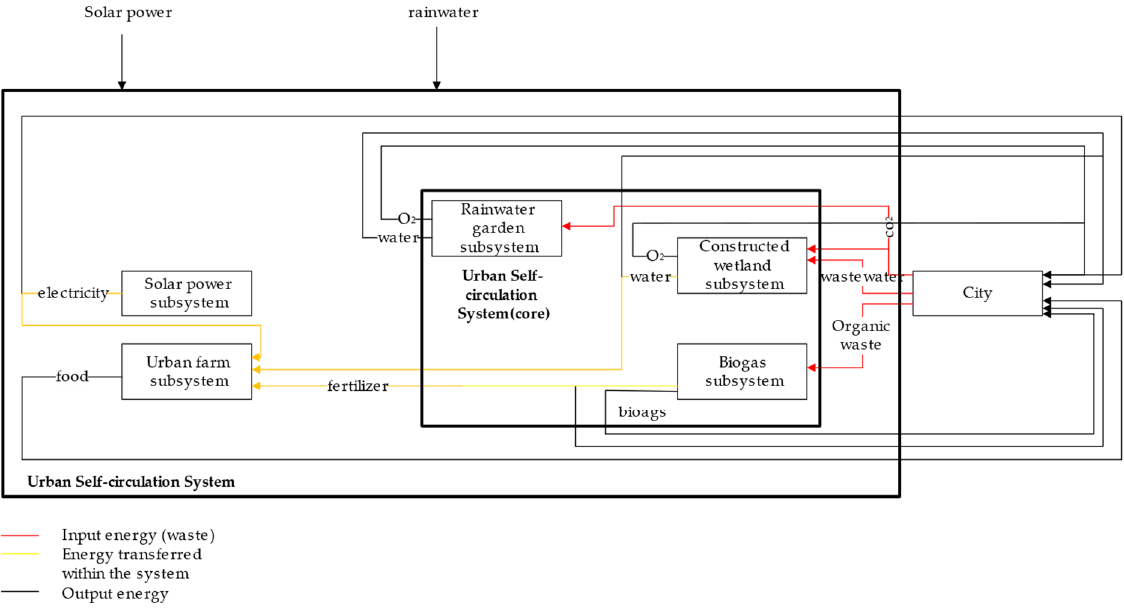
Figure 1. Urban Self-circulation System.